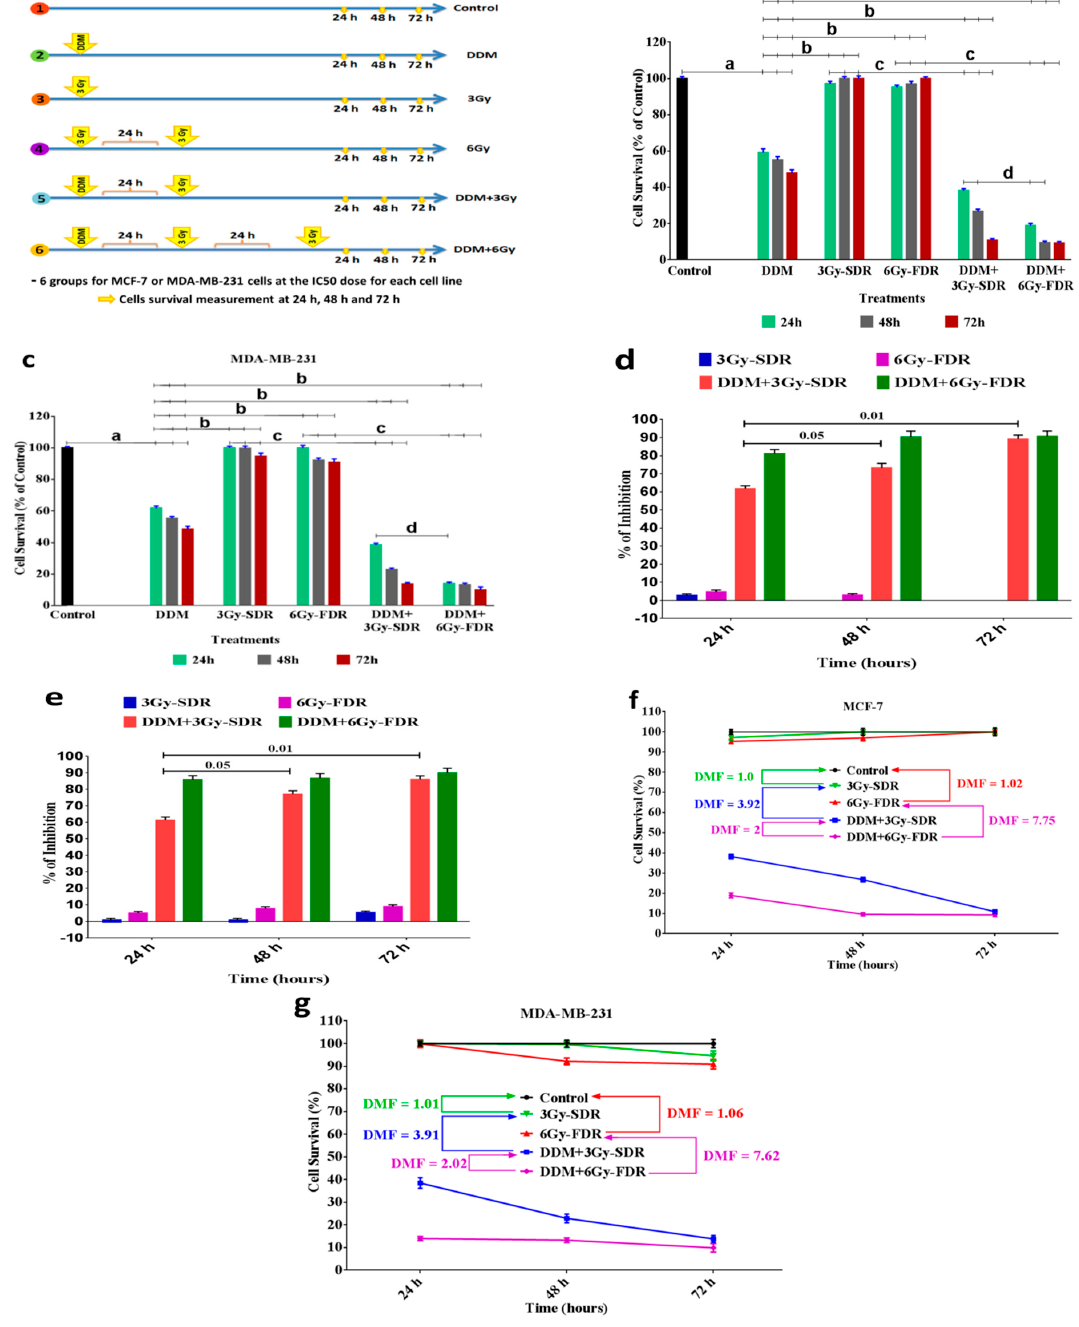
Figure 4. Cell survival and radio-sensitization rates using the multi-MTT assay. ( a ) Experimental schematic outline of the six different treatment groups. Evaluation of cell survival ( b , c ), percent inhibition for MCF-7 ( d ), percent inhibition for MDA-MB-231 ( e ), and dose-modifying effect curves ( f , g ) in response to DDM, 3Gy-SDR, or 6Gy-FDR, and a combination of both at 24 h, 48 h and 72 h using the multi-MTT assay. Data are the mean ± standard error of the mean (SEM), where control cells are 100% ( n = 3). a p < 0.01 vs. control; b p < 0.01 vs. DDM group; c p < 0.001 vs. 3Gy-SDR or 6Gy-FDR groups; d p < 0.05 vs. 3Gy-SDR+DDM group.